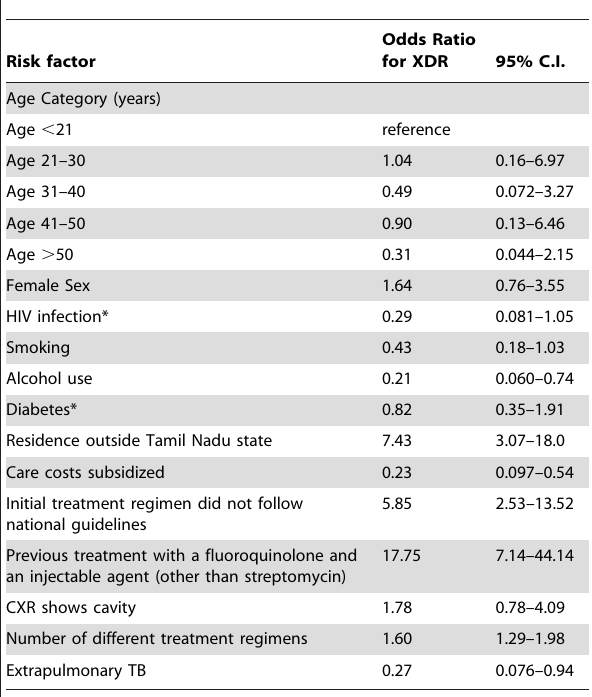
Table 3. Bivariate Analysis: Risk factors for XDR.